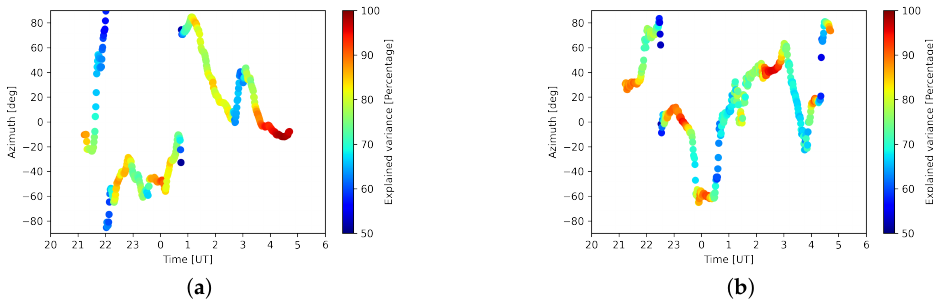
Figure 17. L82655 PCA azimuths for principal components ( a ) at 3 min central period and ( b ) at 12 min central period. Color scale shows percentage of signal’s variance explained by the components.